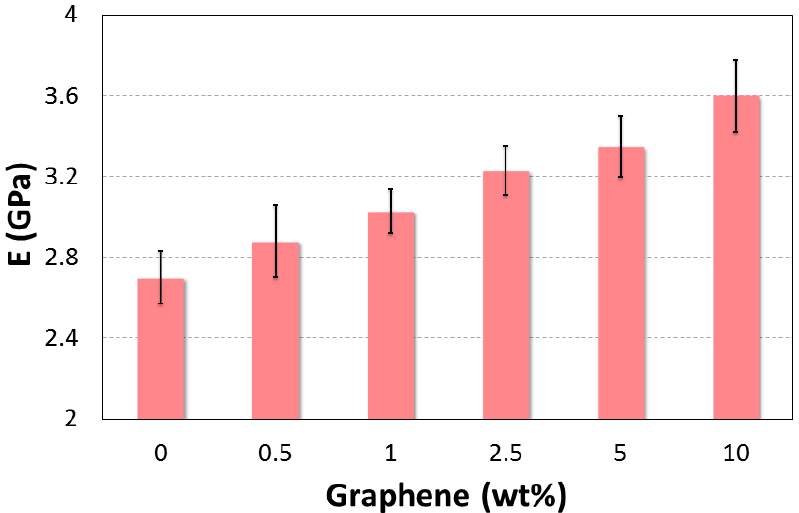
Figure 13. Effect of graphene additives on young modulus.